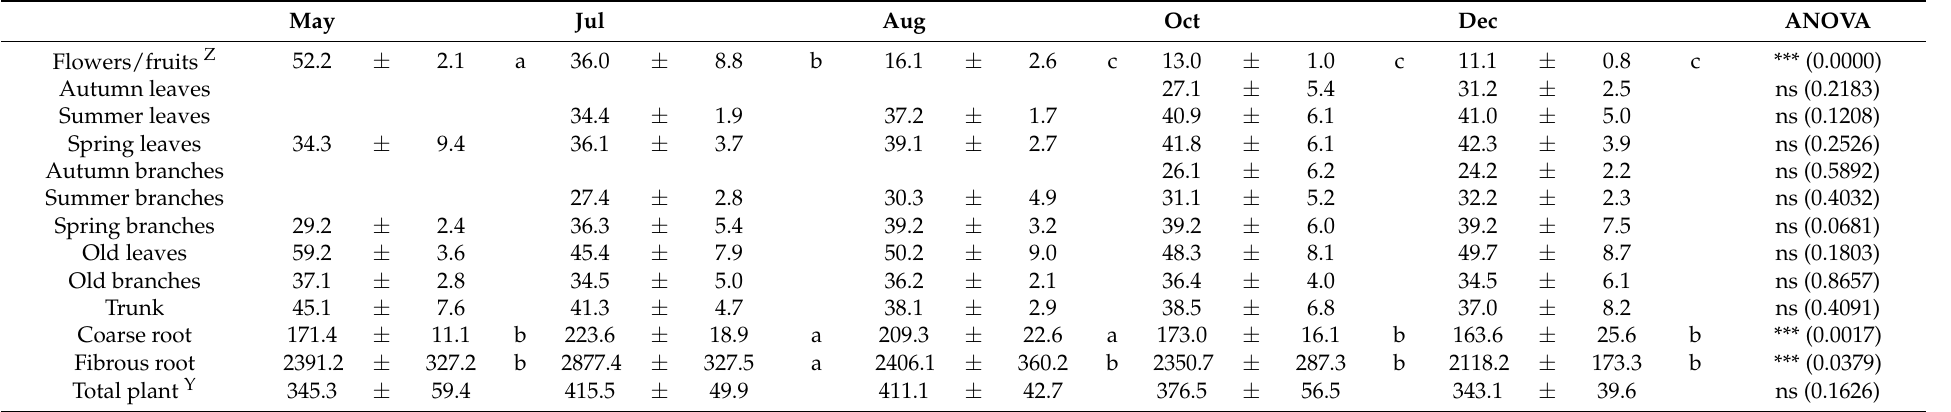
Table 2. Total Fe concentration (mg Fe 1000 gDW − 1 ) in the main organs and ponderated Fe concentration (FePC) Y of Nules clementine trees uprooted in May (flowering), July (fruit set and the end of fruit drop), August (fruit growth), October (fruit growth), and December (fruit maturity). Values are means ± SD (n = 4). Different lowercase letters indicate significant differences based on one-way analysis of variance. Significant effects of the Fe dose applied are given at p ≤ 0.001 (***) and ns (not significance) at each plant component. p -value between brackets (LSD test). DW: dry